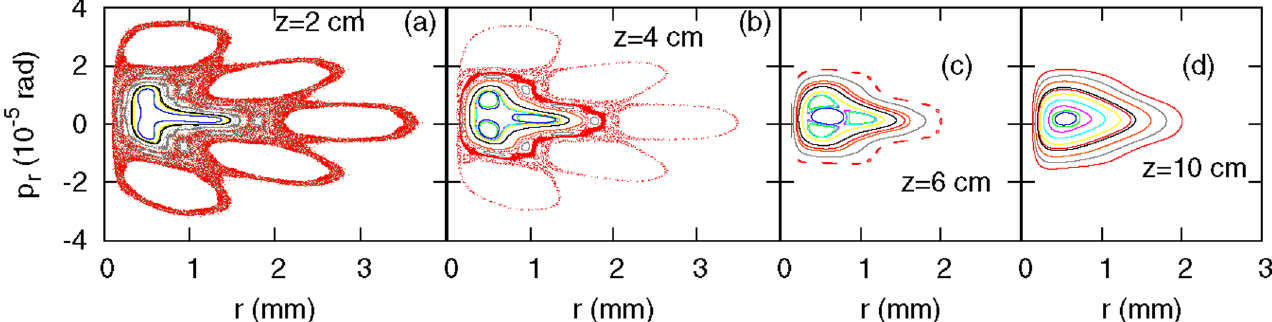
FIG. 6. (Color) Poincare´ plot in r (cid:1) p